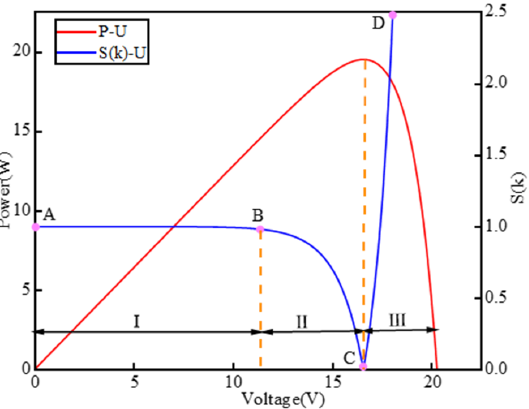
Figure 13. Schematic diagram of three ‐ stage variable step conductance increment method.